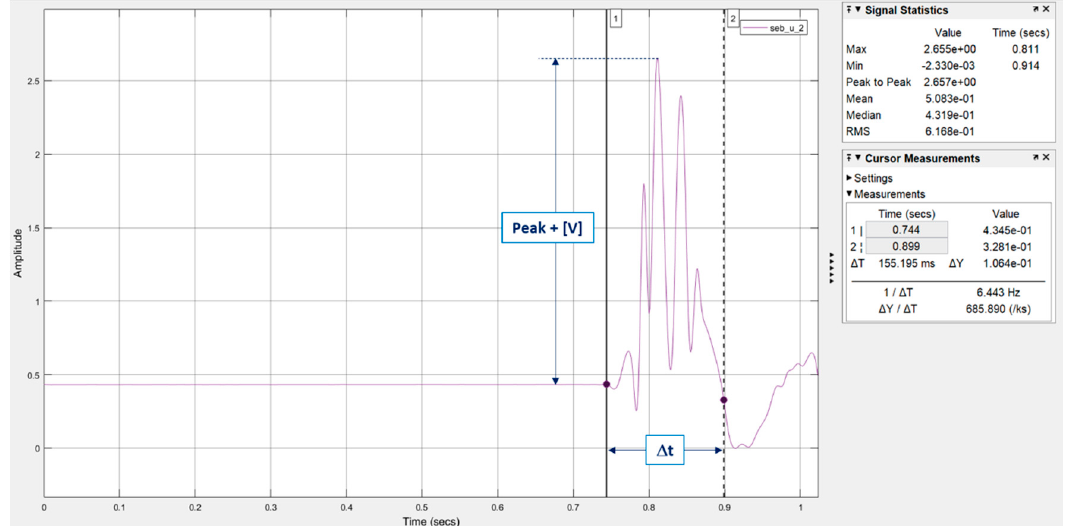
Figure 5. Example of a reading of a shock sensor with a positive measurement of voltage.